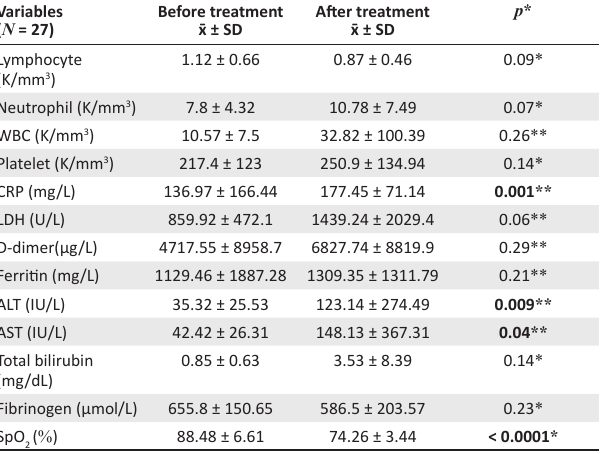
TABLE 3: Comparison of laboratory and clinical parameters before and after lopinavir/ritonavir treatment in non-surviving patients. Variables ( N =